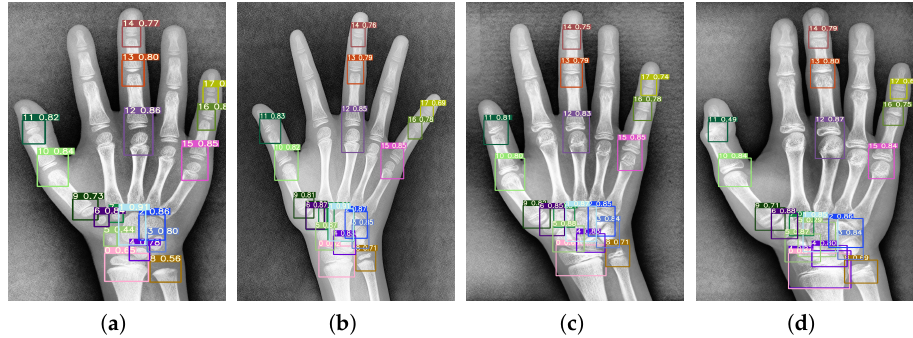
Figure 5. The features of 18 key regions based on ( a ) 4-year-old; ( b ) 8-year-old; ( c ) 12-year-old; ( d ) 15.5-year-old left-hand X-rays.